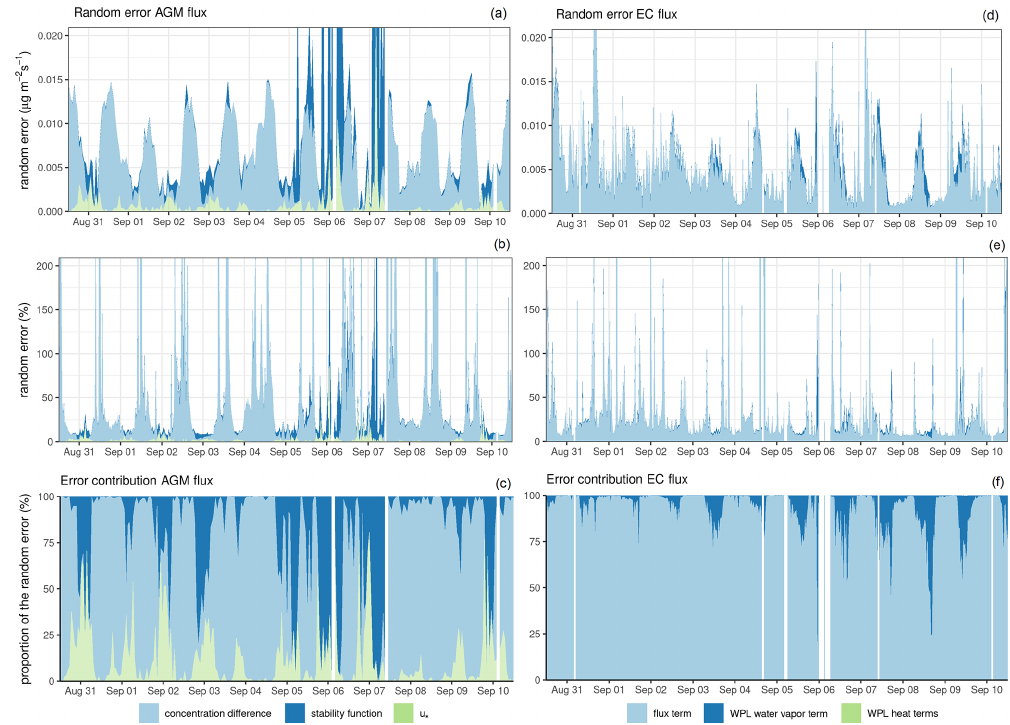
Figure 10. The random error in µgm − 2 s − 1 ( a, d ), random error in % ( b, e ) and proportion of the random error in % ( c, f ) of the AGM (a, b, c) and EC (d, e, f) NH 3 fluxes from 31 August to 10 September. For the EC fluxes, the light blue component (flux term) refers to F1 in Eq. (S2) in the Supplement, based on fluxes determined using EddyPro, taking into account the damping correction and term A from Eq.